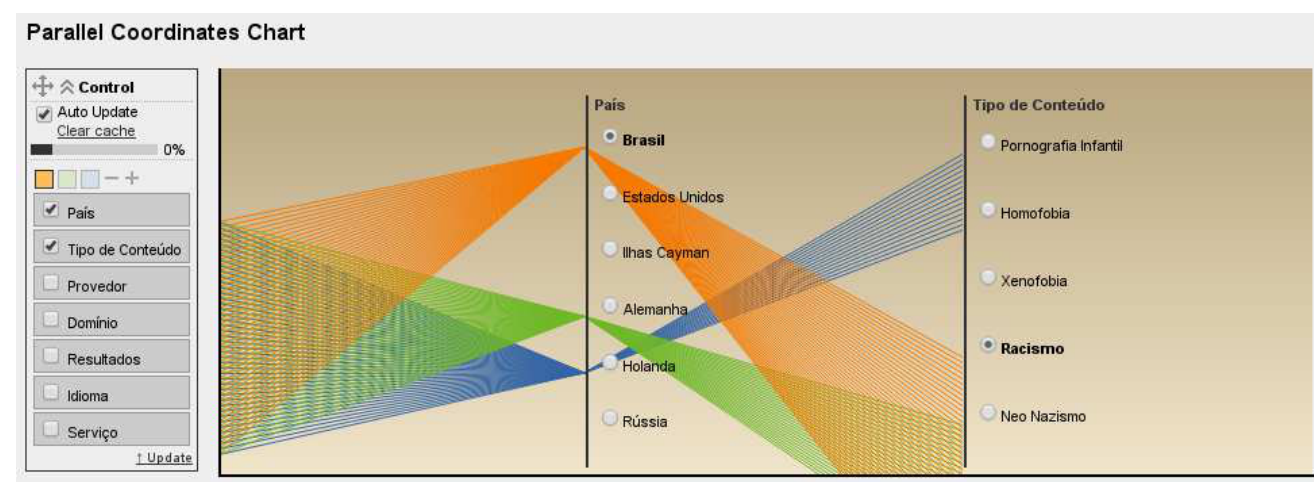
Fig. 7. Parallel bars: dynamic-width polygonal lines for each subset of the input dataset